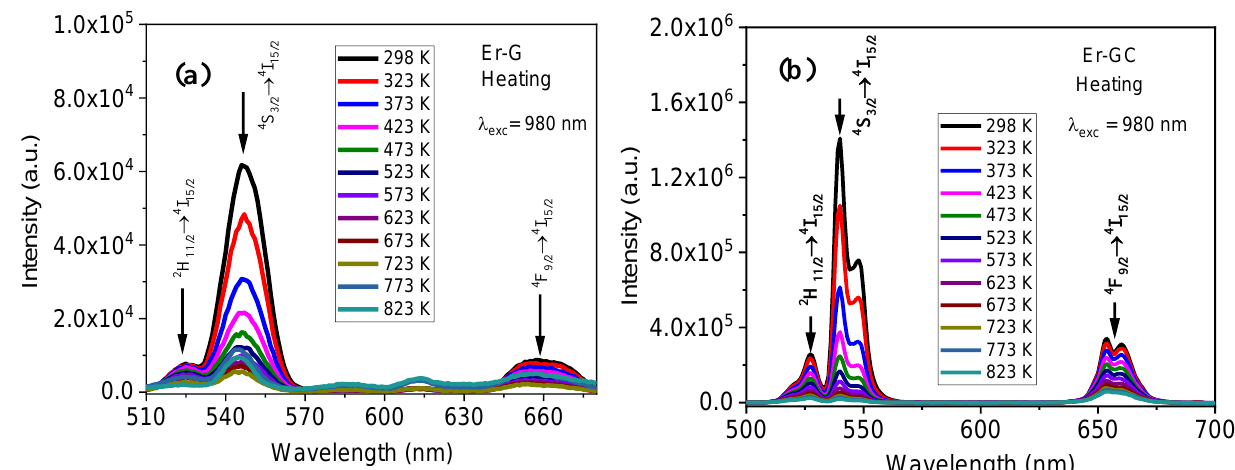
Molecules 2021 , 26 , x FOR PEER REVIEW Figure 9. UC PL spectra measured at different temperatures when heating the samples, ( a ) Er-G and ( b ) Er-GC. The FIR of transitions, G 1 /G 2 (attributed from TCLs) increased with increasing tem- perature from 298 K to 673 K, then decreased in the Er-G sample (Figure 10a). On the other hand, the FIR of the same transitions in the Er-GC sample increased with increasing tem- perature (Figure 10c). In Er-G and Er-GC samples, FIR of transitions, R/G 2 (attributed from NTCLs) increased (Figure 10b,d) with increasing temperature from 298 K to 823 K. Above 700 K, the FIR of transitions, G 1 /G 2 , and R/G 2 rapidly changes in Er-G. This could be at- tributed to the fcat that the intensity ratio of G 1 /G 2 lines no longer follows the Boltzmann distribution due to thermal saturation, and the kinetics of green and red emission may differ at high and low temperatures. Furthermore, when Er-G and Er-GC samples were cooled, the FIR of TCLs and NTCLs levels are the same as in heated samples (except at 823 K in Er-G). The FIR of transitions attributed to TCLs (Figure 10a,b) and NTCLs (Figure 10b,d) against temperature (for Er-G sample taken into account up to 673 K) was fitted by expo- nential equation, Equation (1), and polynomial equation, Equation (4), respectively, shown in Figure 11 for Er-GC sample and in Figure S1 in Supplementary Material for the Er-G sample.